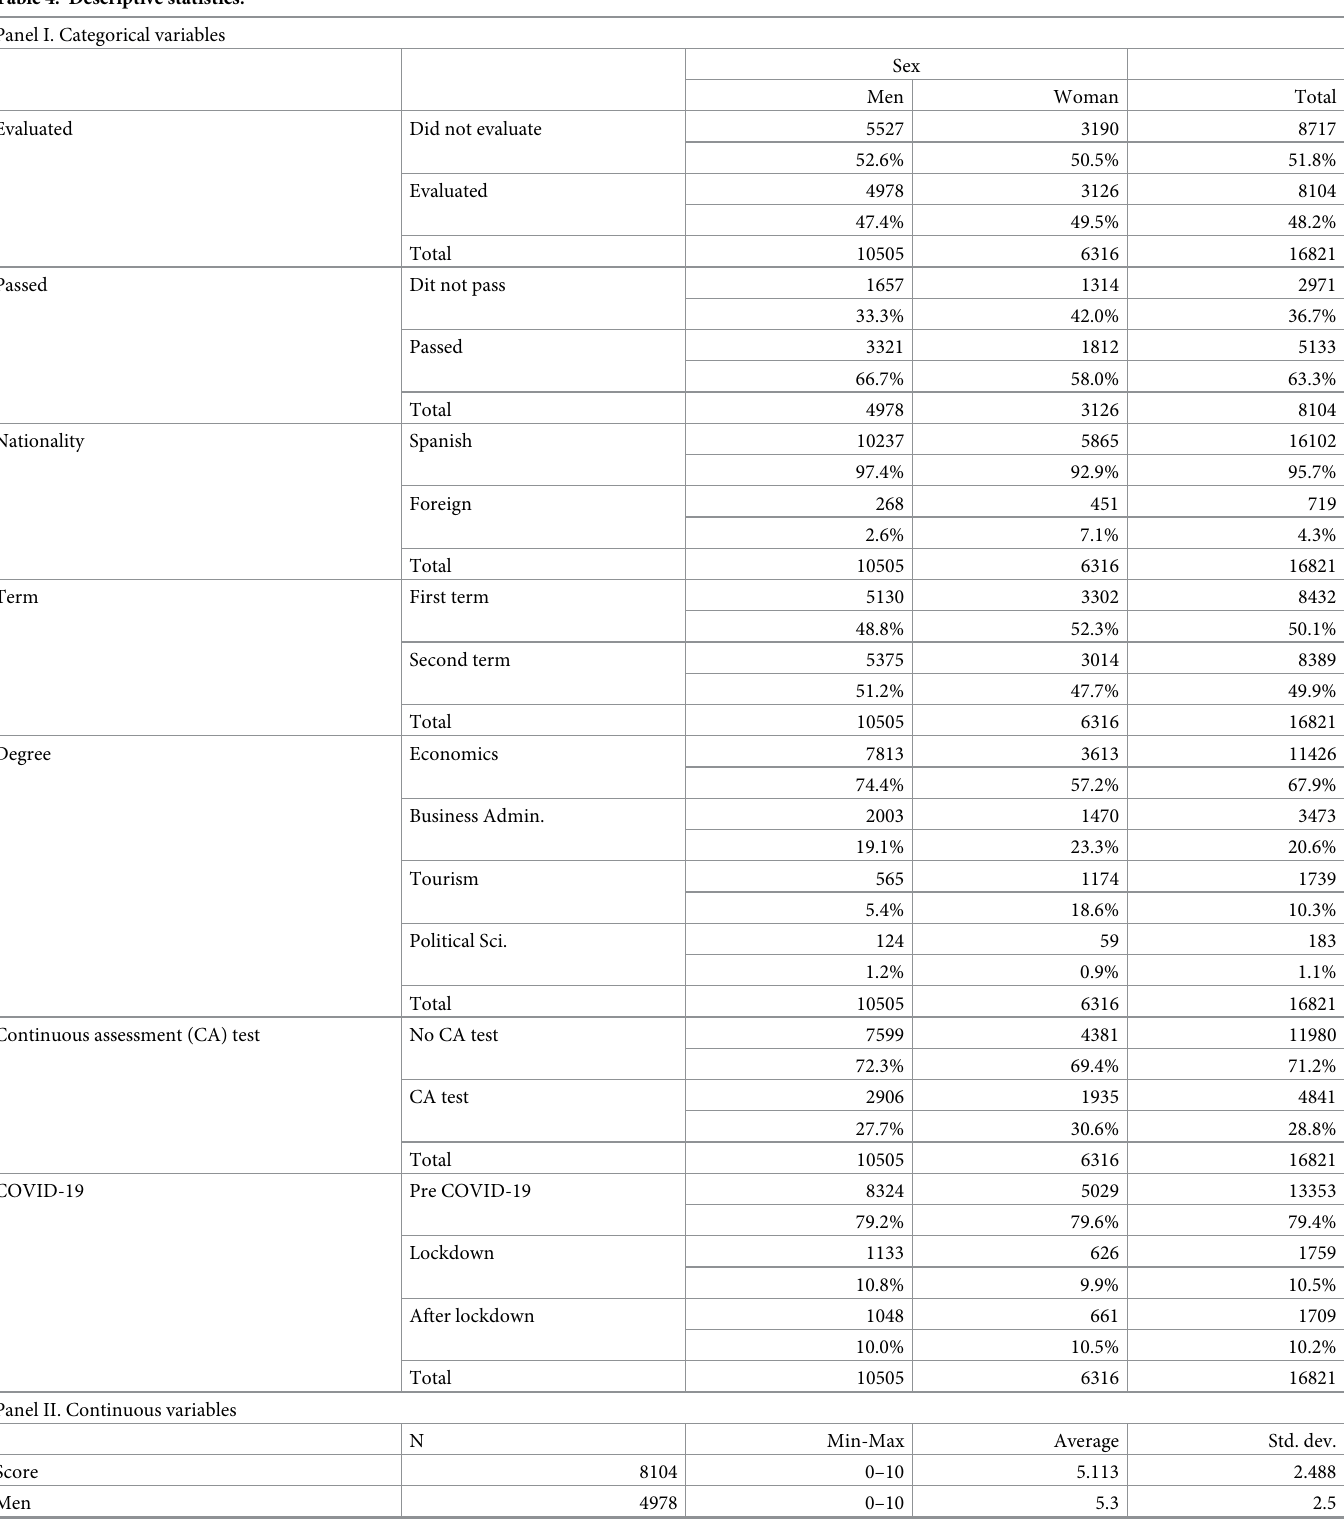
Table 4. Descriptive statistics. Panel I. Categorical